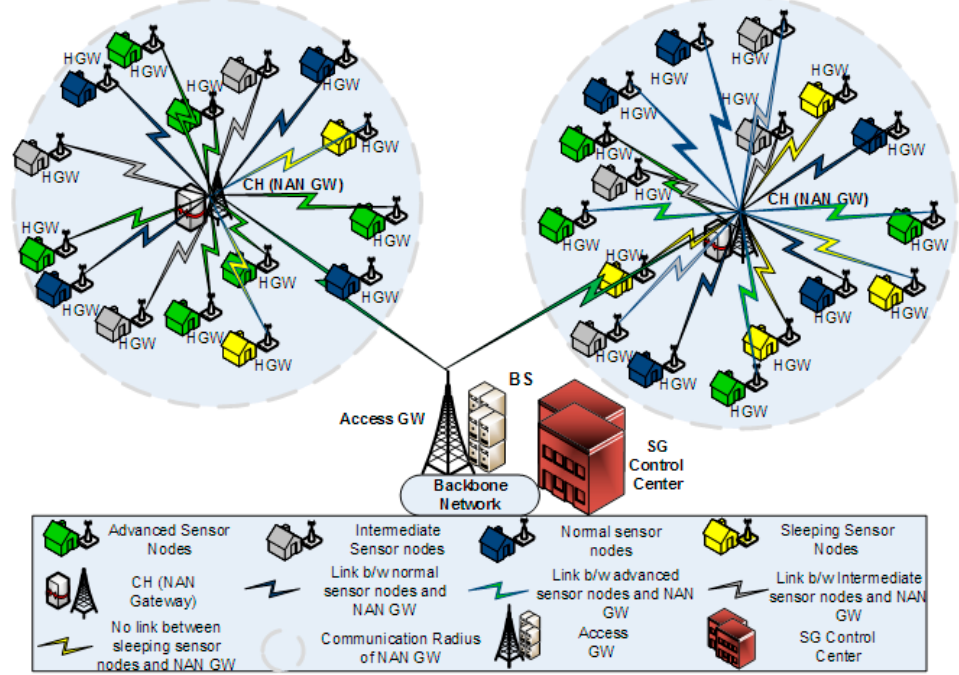
Figure 2. Hesitant fuzzy entropy (HFE) based opportunistic clustering for neighborhood area networks. Table 2. Interval for each attribute used for data standardization.